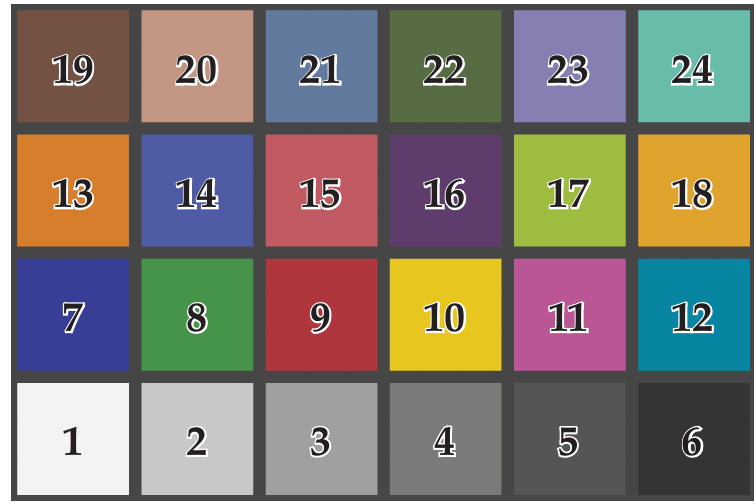
Figure 2. The measured target X-Rite ColorChecker Classic and the patch numbers used in this